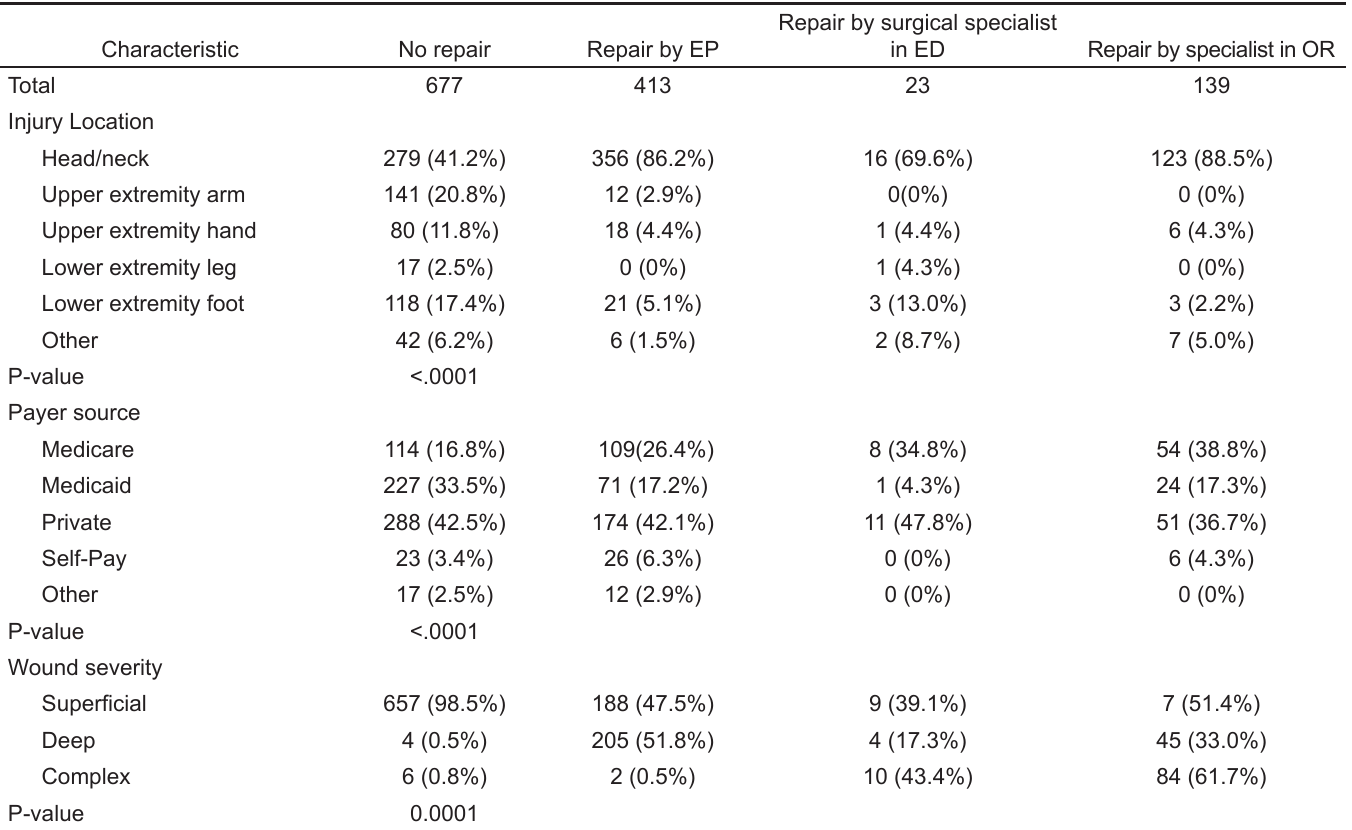
Table 3. Level of intervention by injury location and payer source.